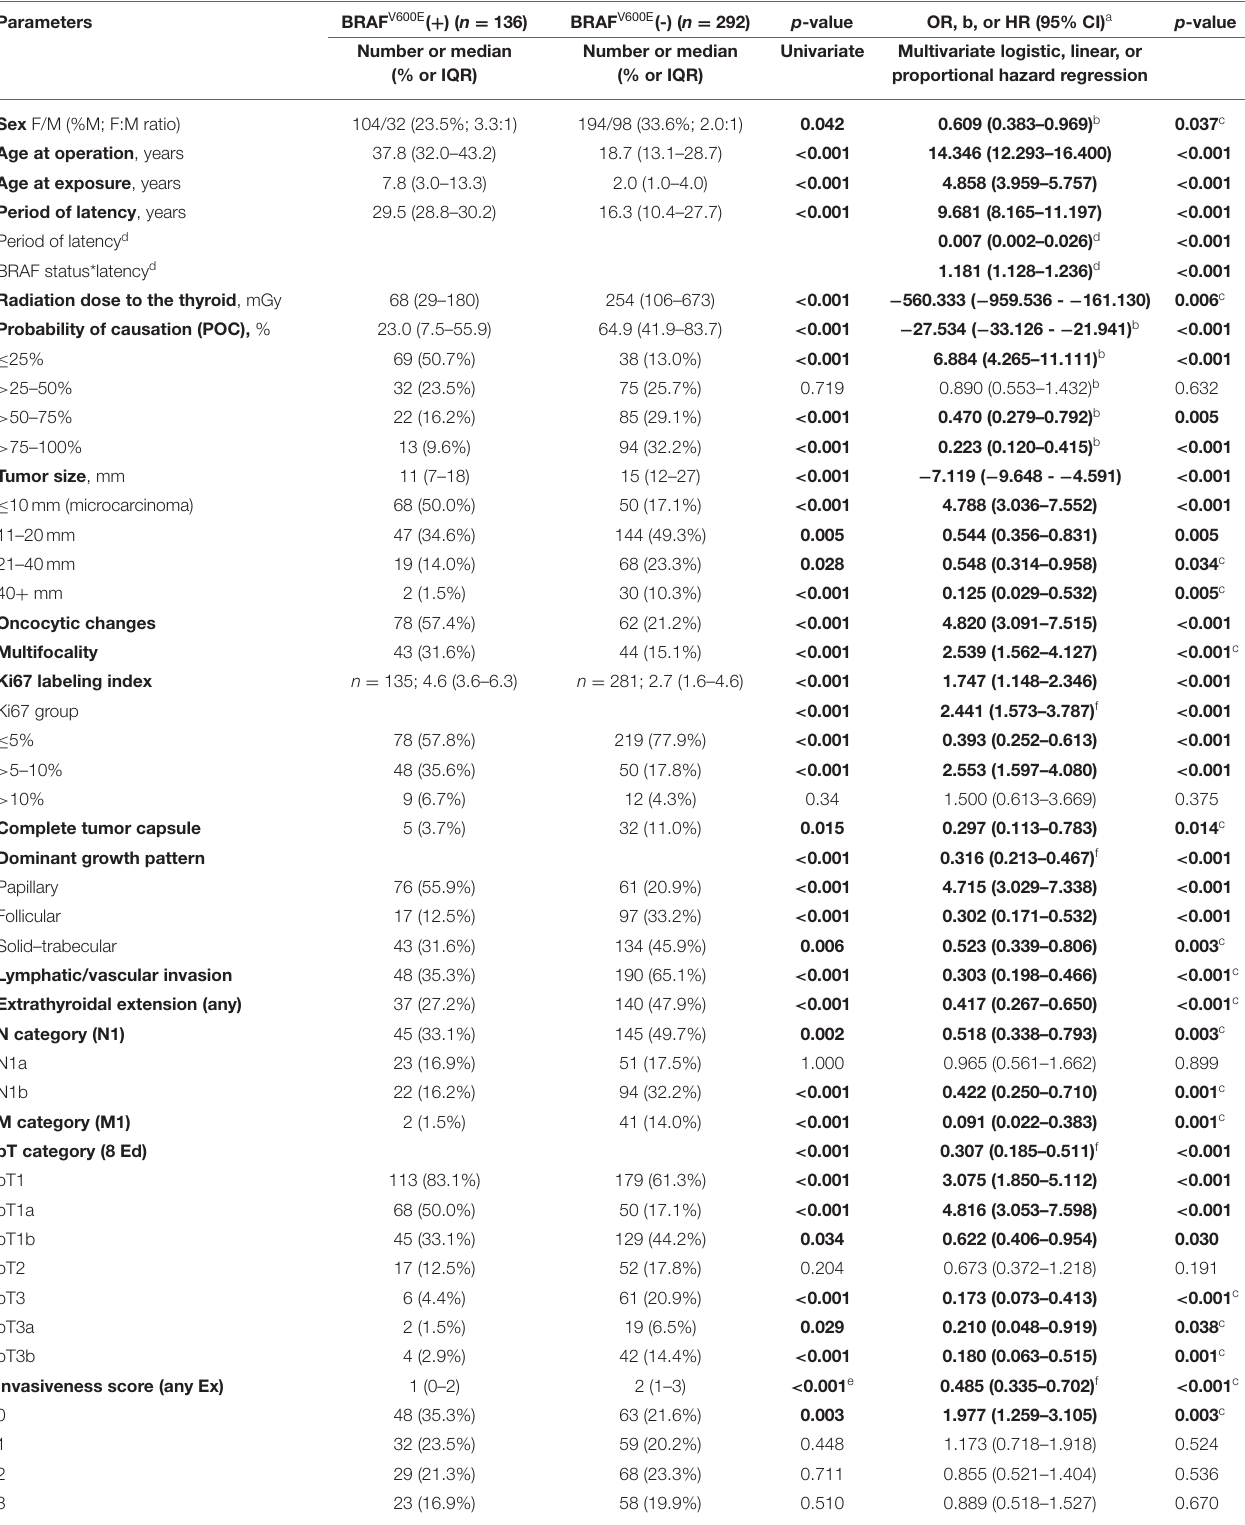
TABLE 1 | Comparative characteristics of the BRAF V600E -positive versus BRAFV 600E -negative PTCs.